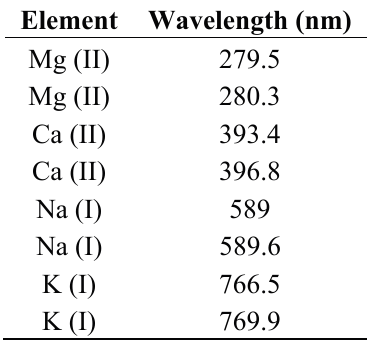
Table 4. Table of matrix elements utilized in multivariate